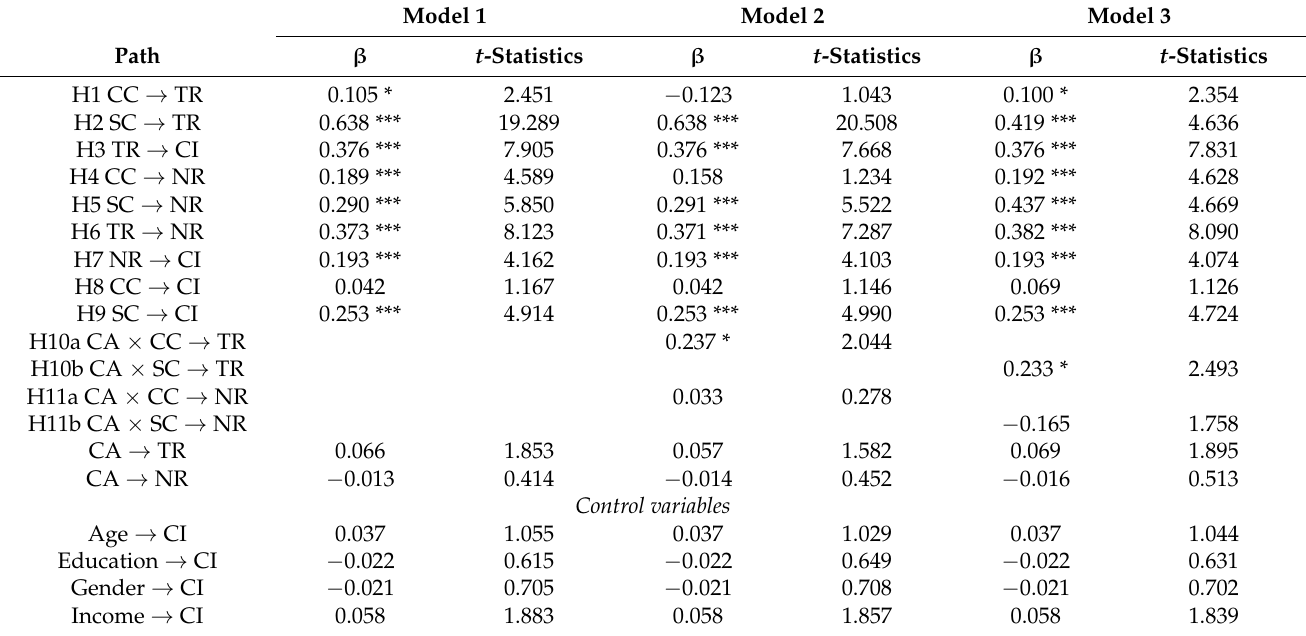
Table 5. Structure model path analysis.